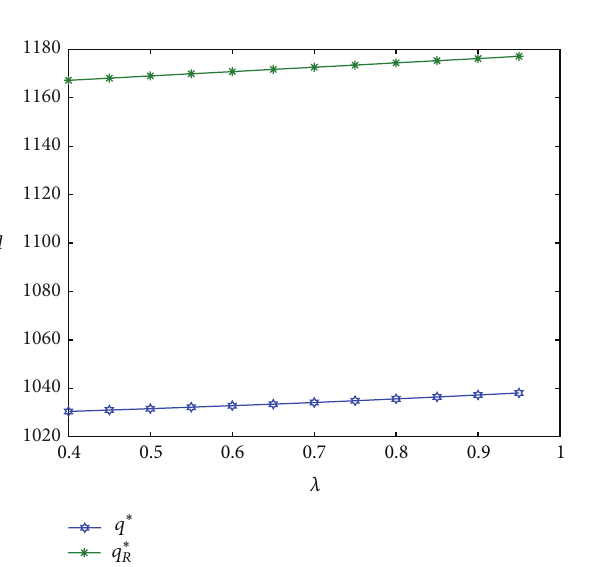
Figure 12: Impacts of 𝑇 on Ψ ∗ and 𝑓 ∗ .